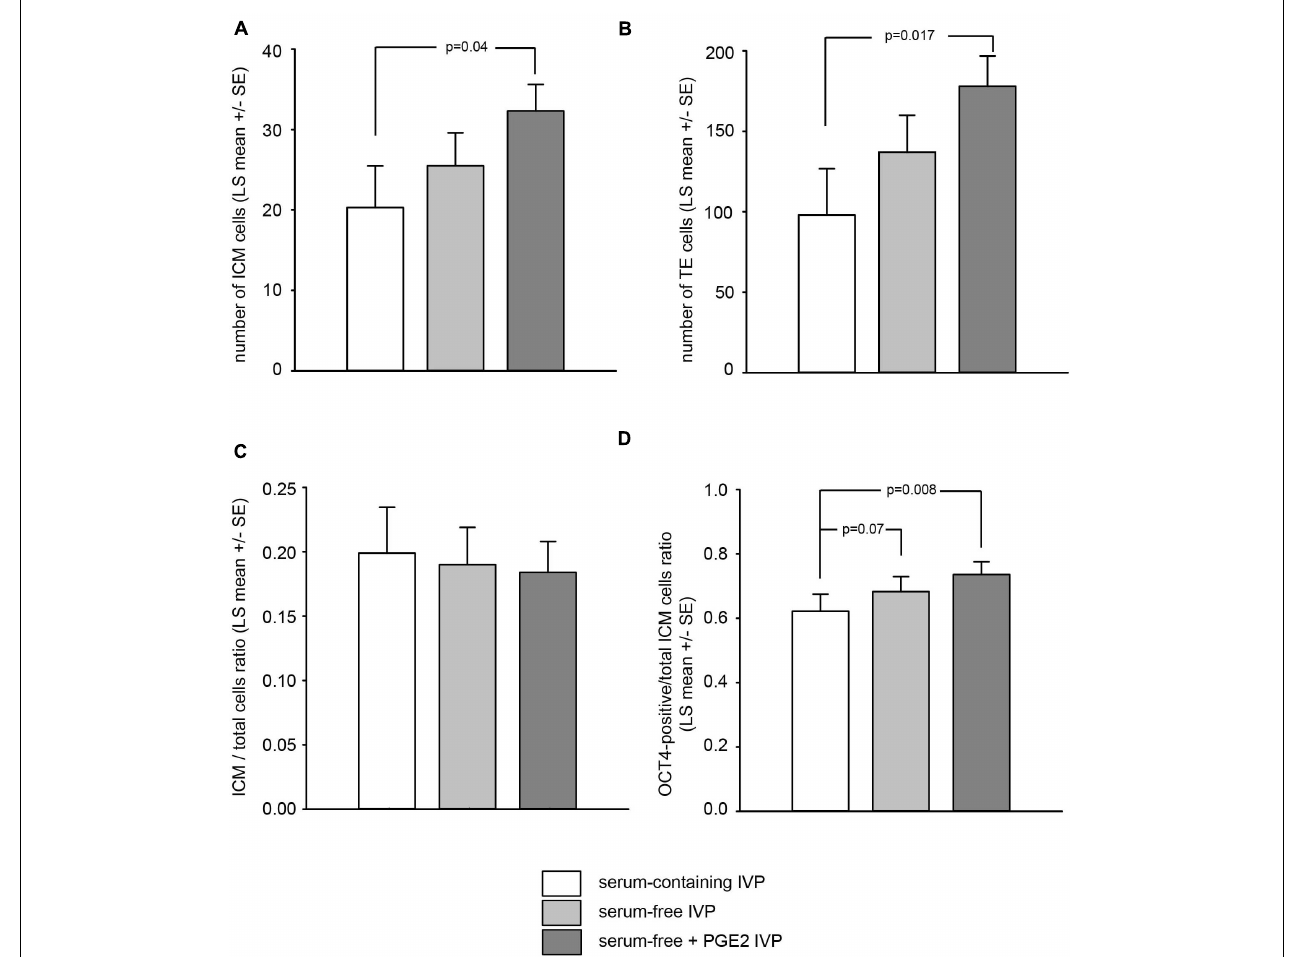
FIGURE 3 | Culture conditions used during the in vitro production (IVP) of bovine blastocysts alter the total number of ICM cells (A) , trophectoderm cells (B) , and the proportion of OCT4-positive ICM cells relative to the total number of ICM cells (D) on day 3 after thawing. The proportion of ICM cells relative to the total number of blastomeres was unaffected by IVP conditions (C) . Samples sizes for embryos derived from “serum-containing,” “serum-free” and “serum-free + PGE2” in vitro production conditions were n = 18, 25, and 43, respectively. Values are represented as LS mean ±